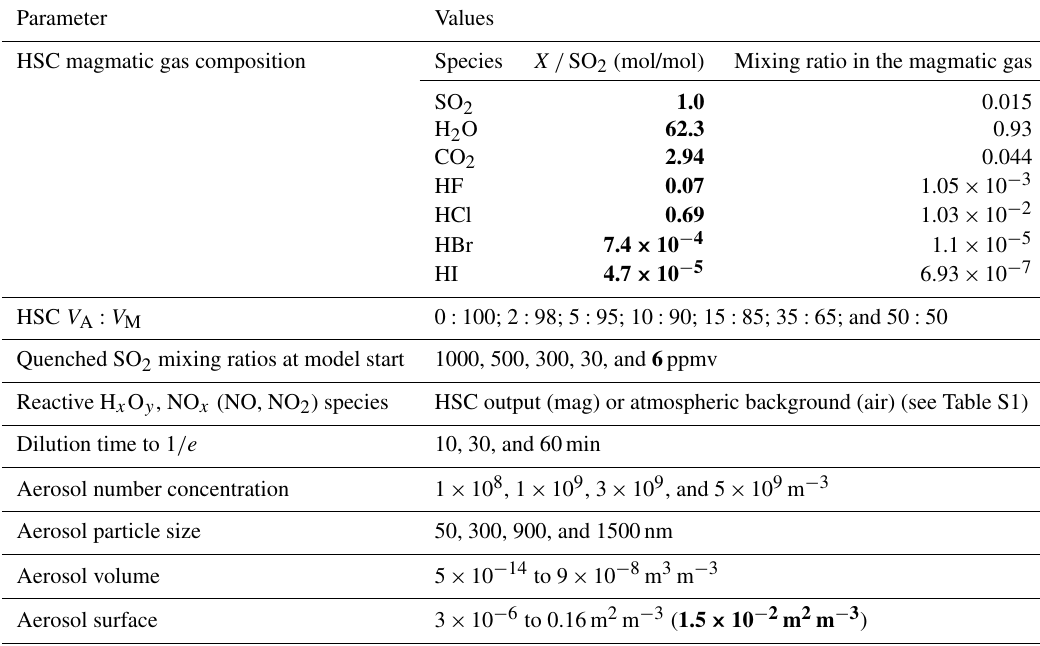
Table 3. Thermodynamic (HSC) and box (CAABA/MECCA) model parameters. Bold text is used to represent parameters measured at the Santiago crater rim.